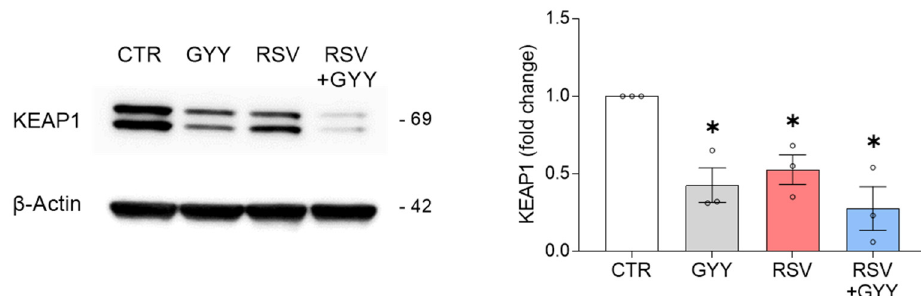
Figure 3. H 2 S donor GYY4137 downregulates KEAP1 in RSV infection. SAECs uninfected and in- fected with RSV were treated with 5 mM GYY4137 or its vehicle. Cells were harvested 18 hpi and total cell lysates were analyzed by Western blot with anti-KEAP1 antibody. The membrane was reprobed with anti- β -actin antibody for loading control. Western blot image is one representative of three independent experiments. Graph shows the densitometric analysis of KEAP1 after normalization to β -actin expressed as mean ± SEM. Data were analyzed by two-way ANOVA followed by Tukey’s test (* p < 0.05 vs. CTR).